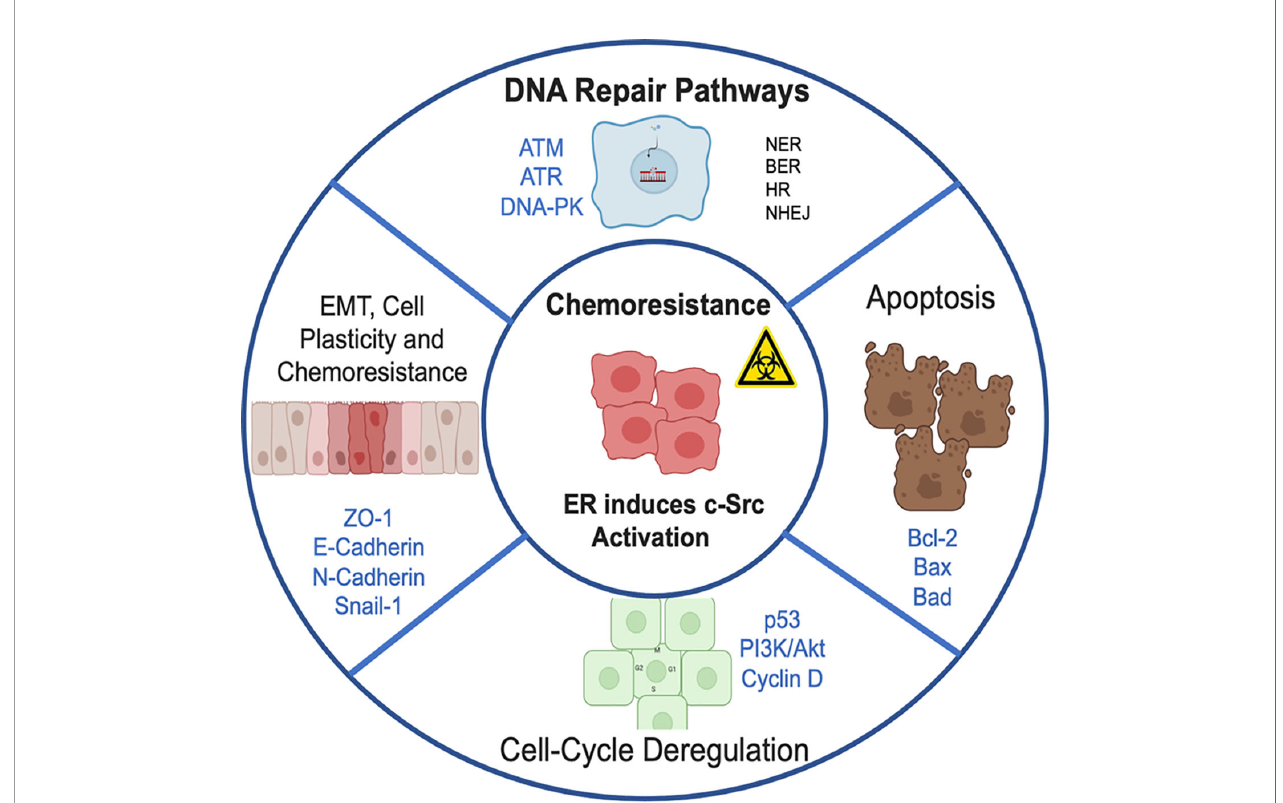
FIGURE 1 | Chemoresistance pathways induced by estrogen receptor, through the direct activation of c-Src kinase. Conventional radiotherapy and chemotherapy kill most cancer cells, but there are some that can evade the cytotoxic effects of treatment and restart accelerated tumor proliferation. This promotes cancer recurrence and subsequent metastasis. Chemoresistance can be ascribed to 1) Resistance induced by altering DNA repair pathways (NER, nucleotide excision repair; BER, base excision repair; HR, homologous recombination; NHEJ, non-homologous end-joining). 2) Inhibition of apoptosis and activation of pathways involved in cell survival. 3) Abnormal expression of proteins that regulate cell cycle progression. 4) High plasticity of tumor cells with which they activate the process of EMT, epithelium-mesenchymal transition that facilitates migration and invasion to distant